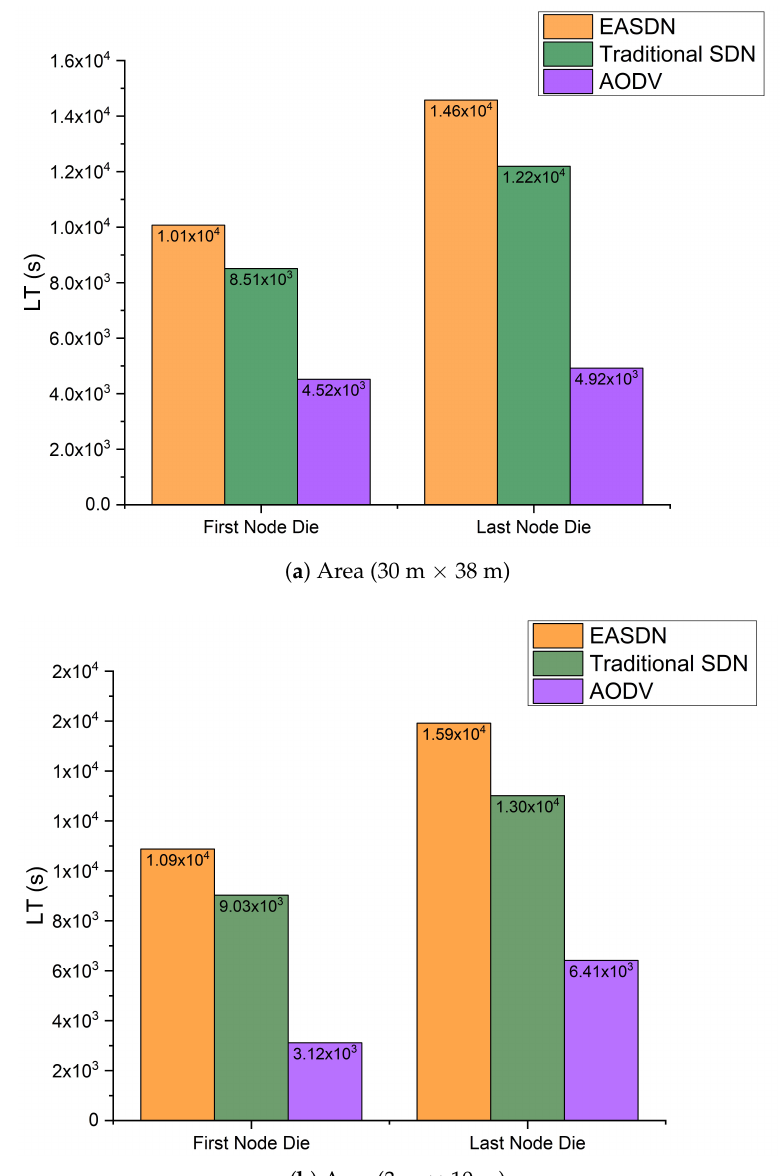
Figure 11. Network